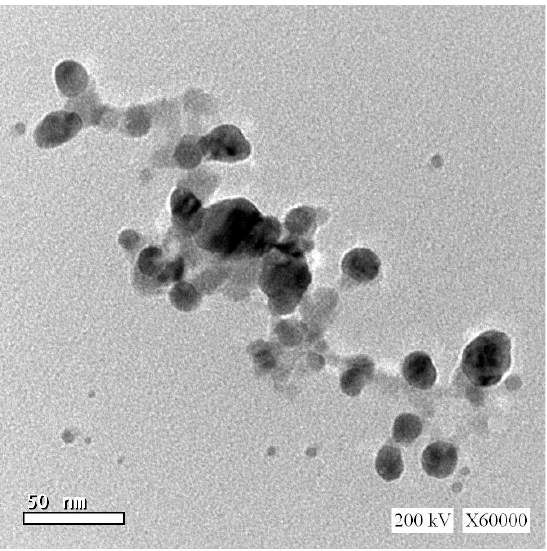
Figure 1. Transmission electron microscopy diffraction patterns for iron oxide nanoparticles.